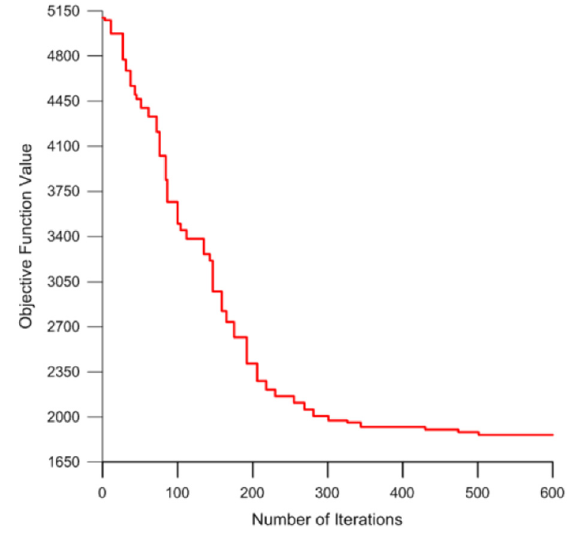
Fig. 15. Optimal layout for the planar 47-bar truss problem Fig. 16. Convergence history for the planar 47-bar truss using